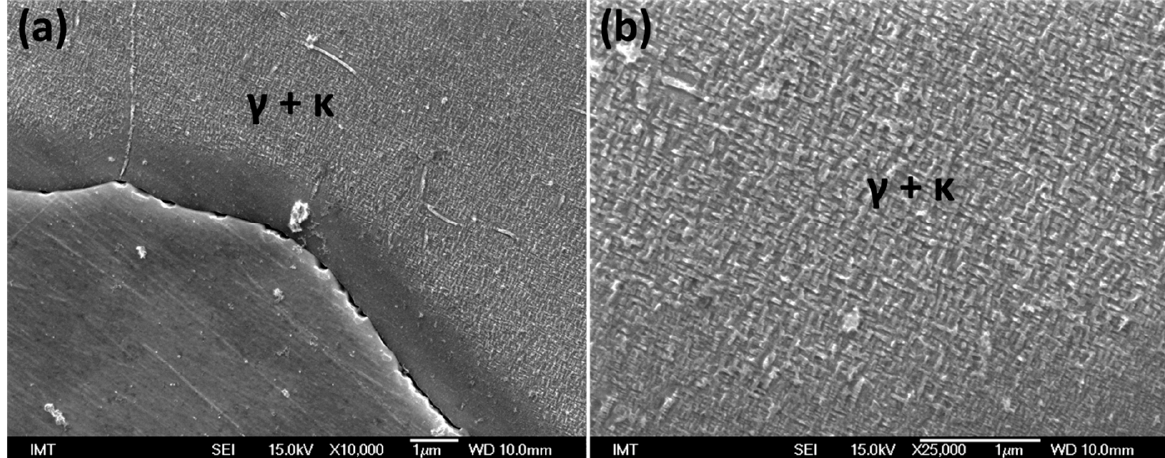
Figure 12. High magnification of the as-cast sample etched with 10% nital, ( a ) the austenite phase contains an ordering about a µm from the ferrite–austenite phase boundary, while the ferrite is precipitate free, ( b ) a more detailed image of the austenite containing ordering like precipitates.